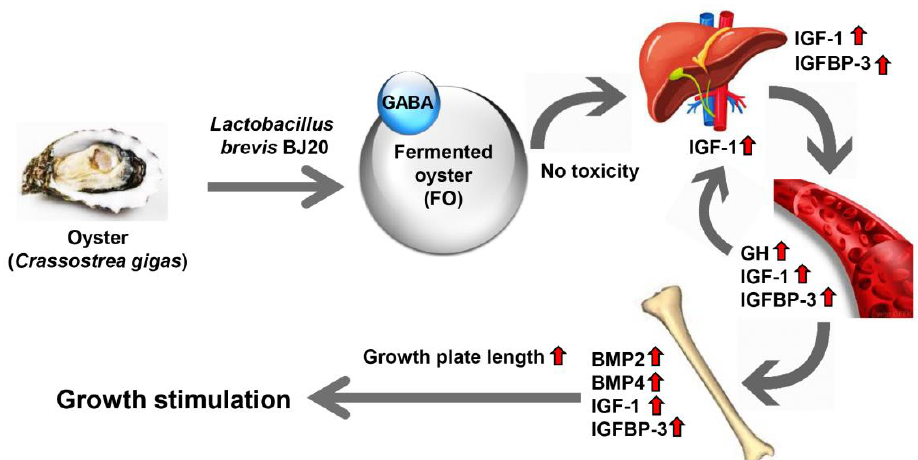
Figure 6. GABA-enriched FO promoted the length of the growth plate on the longitudinal bone in the Sprague-Dawley rats.